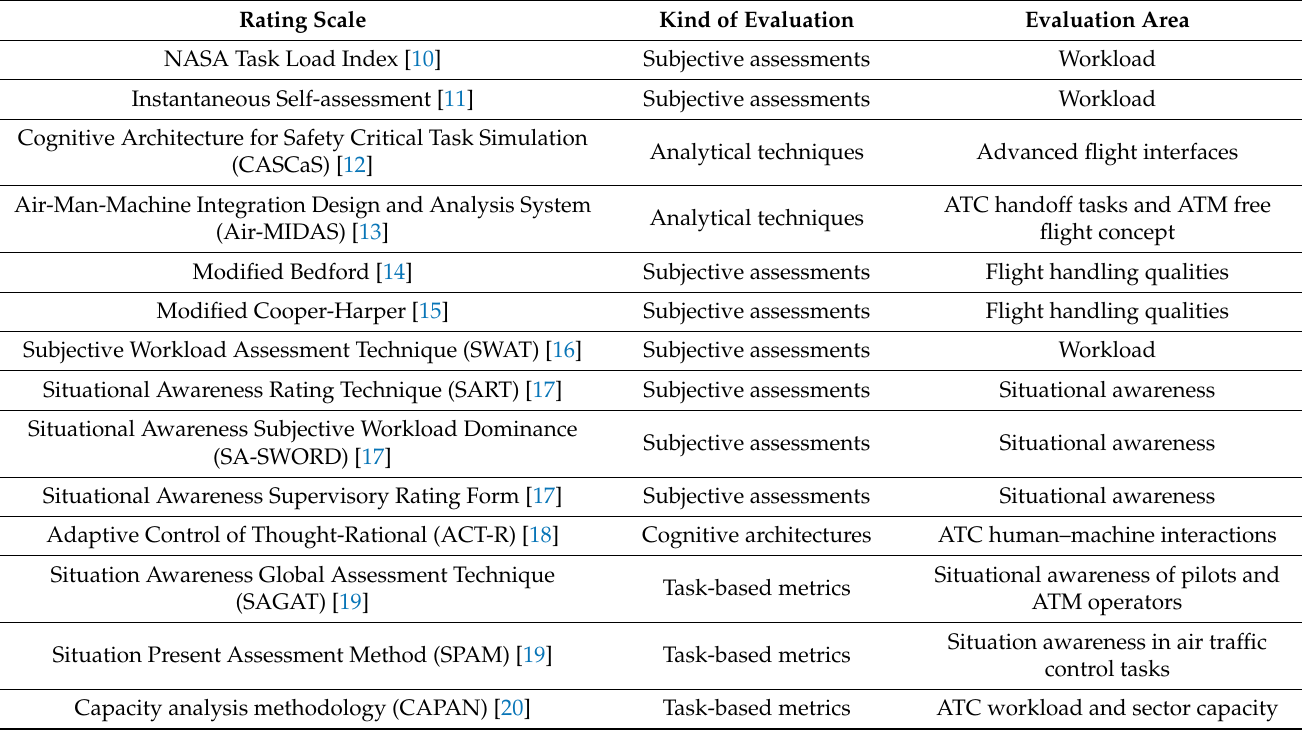
Table 1. Human factor rating scales in the aviation